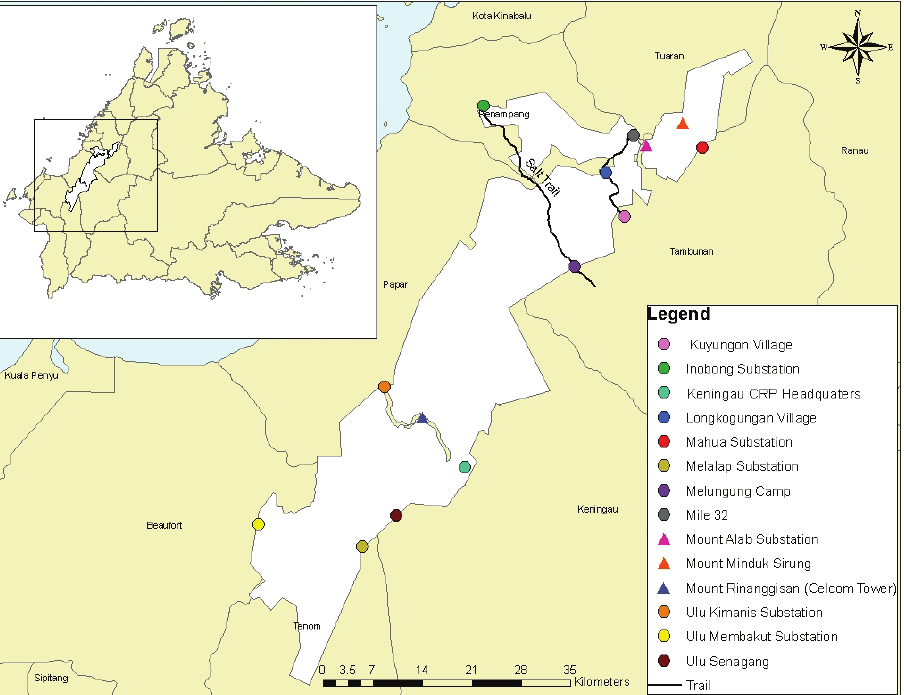
Figure 1. Map of Crocker Range Park showing the localities of collections from the year 2002 to 2008. Inset is map of Sabah, Malaysian